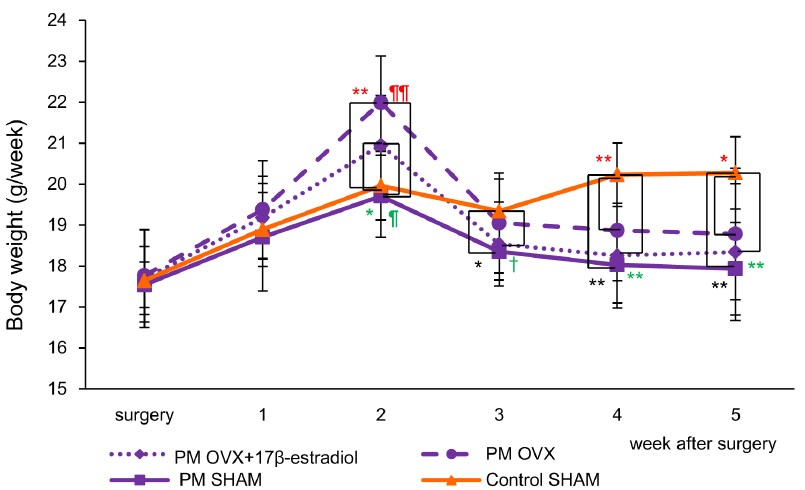
Fig. 2. Body weight. The body weights of each group are shown on line graphs for each week. Values are expressed as mean ¡ SD, n 5 15, in Control SHAM, PM SHAM and PM OVX + 17 b -estradiol groups (before treatment with 17 b -estradiol) and 14 in the PM OVX group, ANOVA, Tukey-Kramer * p , 0.05, ** p , 0.01 (in black): Control SHAM versus PM SHAM, * p , 0.05, ** p , 0.01 (in red): Control SHAM versus PM OVX, { p , 0.1,